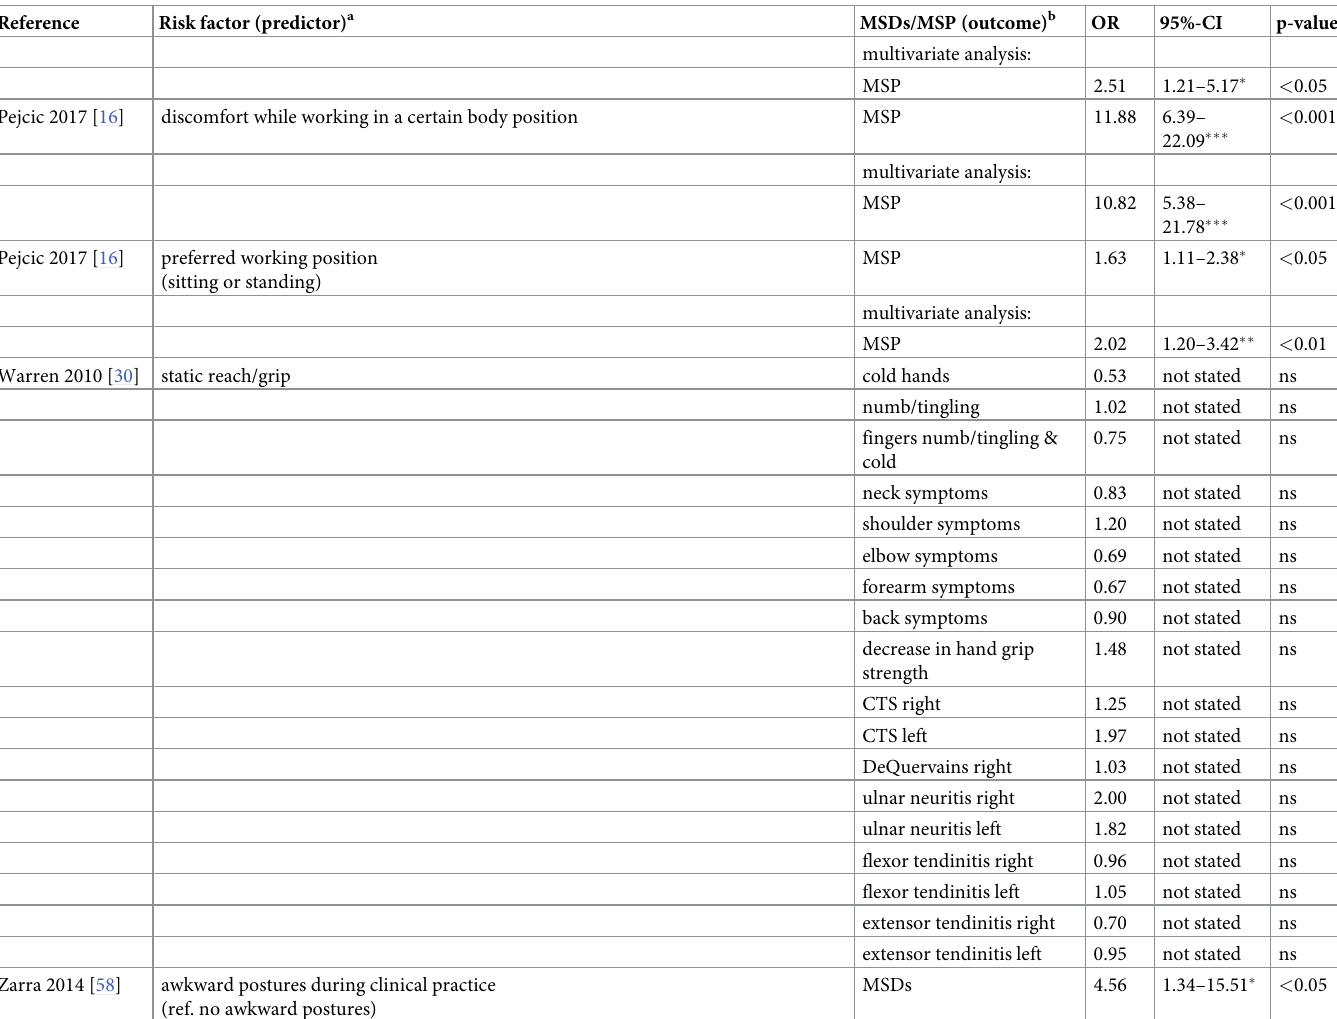
point prevalence was indicated for the lower back 49.2% (95% CI = 33.0–65.4), the neck 42.8% (95% CI = 31.5–54.0), the hand/wrist 33.6% (95% CI = 7.6–59.6), and the shoulders 27.3% (95% CI = 13.0–41.7). For all examined body regions and periods of time, significant heteroge- neity was observed between the included studies (I 2 22.3–99.2%). Heterogeneity was particu- larly high ( > 84%) in 21 (out of 27)